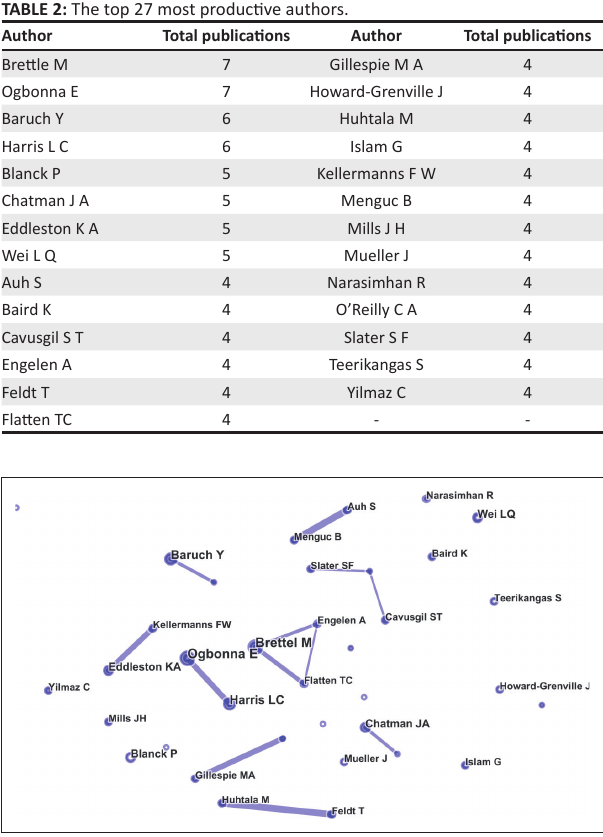
FIGURE 3: Map of the most productive authors with collaborative links.